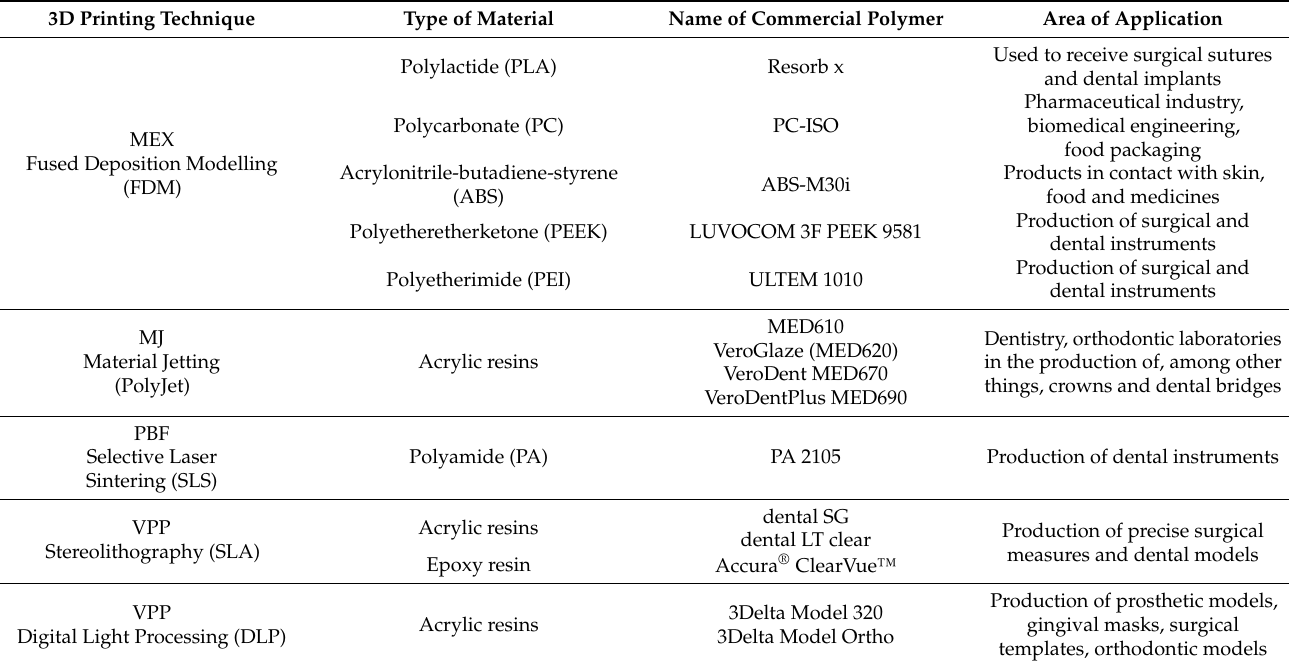
Table 3. Examples of commercial polymer products in the 3D printing process (Adapted with permission from Ref.